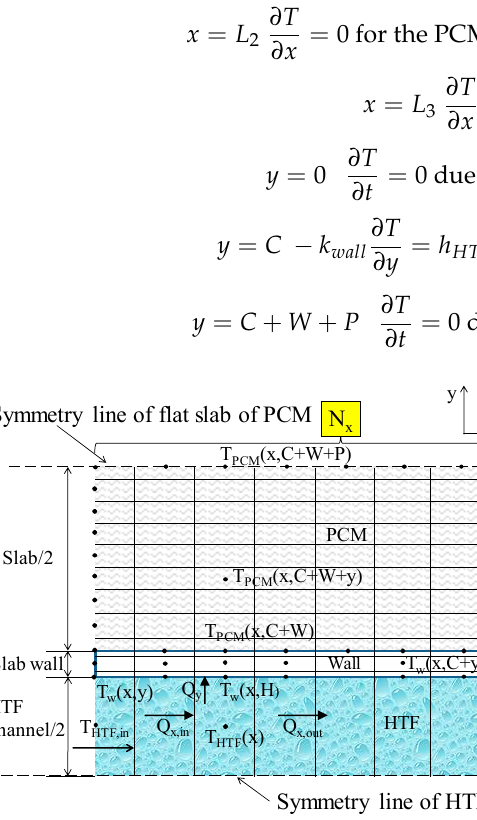
Figure 2. Schematic representation of the nodes of the TES.